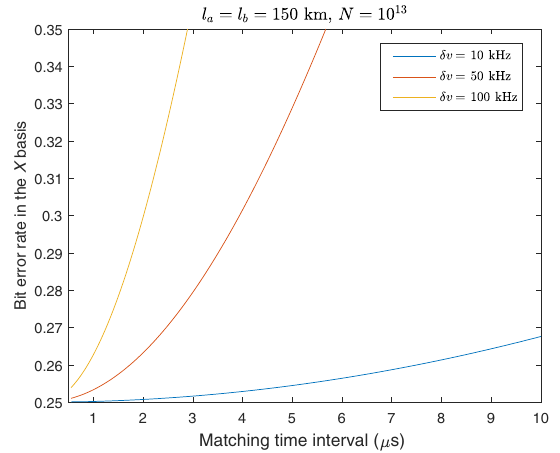
FIG. 7. Secret key rates of the asynchronous MDIQKD with short time matching as a function of the distance when imple- mented without phase tracking. Here, we set the matching time interval T c = 50 μ s, the system repetition rate is F = 1 GHz, and the angle of misalignment in the X basis σ = π/ 10. Our proto- col can break the PLOB bound at a distance of approximately 280 km with N = 10 12 , and the transmission distance reaches 450